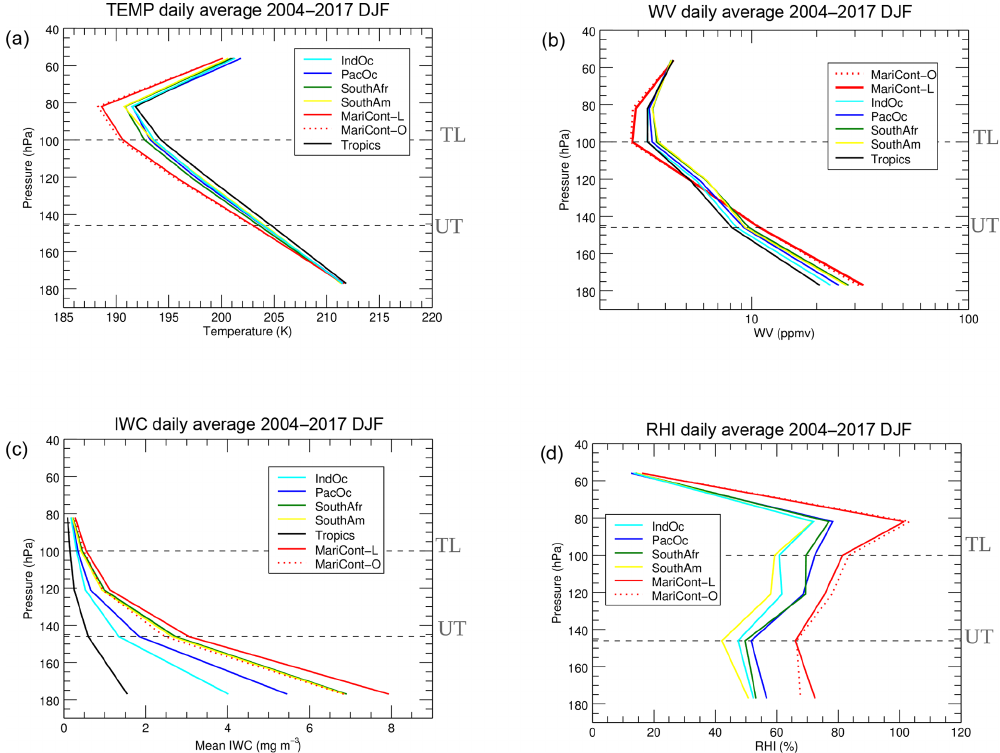
Figure 5. Vertical profiles of (a) temperature, (b) water vapour (WV), (c) ice water content (IWC), and (d) relative humidity with respect to ice (RHI) from MLS data averaged from 2004 to 2017 in DJF over the six study zones: IndOc (light blue), PacOc (dark blue), SouthAfr (green), SouthAm (yellow), tropics (black), MariCont-L (red solid line), and MariCont-O (red dashed